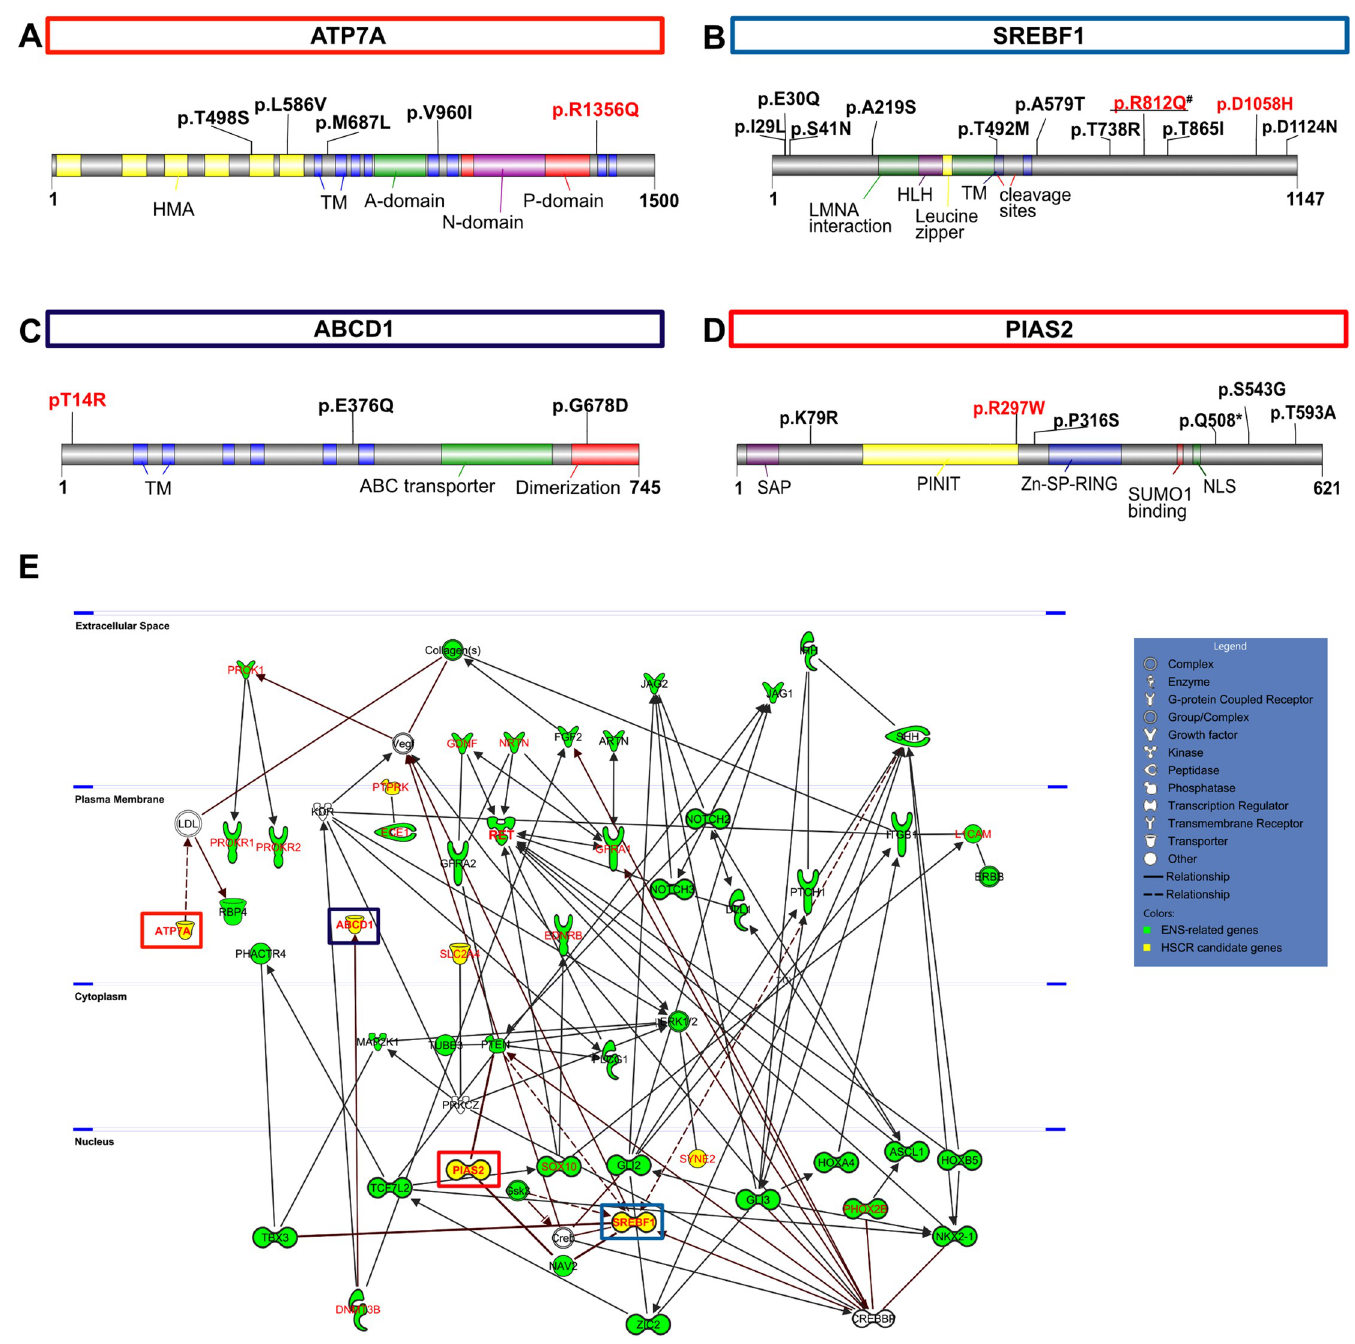
Fig 2. Genetic evaluation of candidate genes and network analyses. (A-D) Disease relevance of all candidate genes was examined by evaluating genetic data from additional patients with HSCR. Variants shown in red were detected in index cases of this study while filtered variants from other cohorts are shown in black (# variant was found in both). More information about the filtered rare variants is given in S4 Table. Protein domain structures and the localization of filtered rare variants are given for ATP7A (A), SREBF1b (B), ABCD1 (C), and PIAS2ß (D). Functional domains in specific isoforms were annotated based on database entries (Pfam, NCBI, Uniprot) or additional literature findings [53,54].HMA: heavy metal associated, TM: transmembrane, A: actuator, N: nucleotide, P: phosphorylation, HLH: helix loop helix, LMNA: LAMIN A/C, ABC: ATP-binding cassette, SAP: scaffold attachment factor-A/B, acinus and PIAS, PINIT: Pro-Ile-Asn-Ile-Thr, Zn-SP-RING: zinc binding —Siz/Pias—really interesting new gene, SUMO: small ubiquitin-related modifier, NLS: nuclear localization signal. (E) IPA core analysis was performed using lists of filtered variants detected in both index cases (S1 and S2 Tables), of ENS-relevant and known HSCR risk factors (S3 Table). Indirect interactions were only kept if linked to candidate gene products. ENS-relevant factors are highlighted in green while validated HSCR risk factors are lettered in red. Candidates are colored in yellow, the four selected most promising candidates are marked by red lettering. Protein interactions between candidates and factors of interest are marked in red. Proteins are arranged according to their subcellular